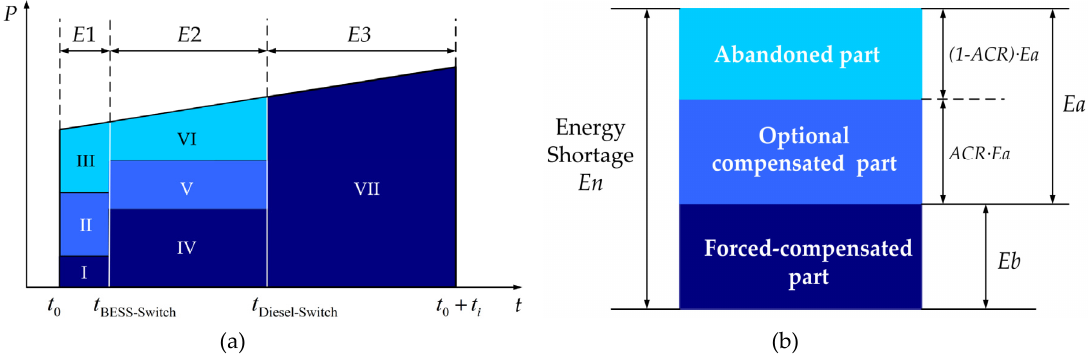
Figure 7. Illustration of discharge strategy with additional compensation ratio ( ACR ) considered. ( a ) Stages of energy shortage; ( b ) Three parts of an energy shortage stage. ACR , additional compensation ratio.